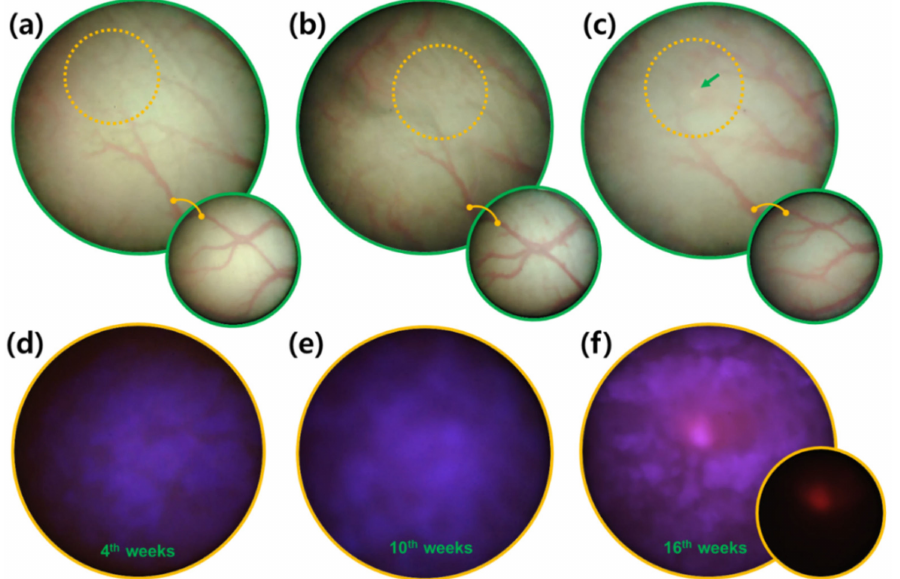
Figure 4. Tracking and monitoring of bladder cancer development. Brightfield and fluorescence images were obtained from the same bladder tissue locations at weeks ( a , d ) 4, ( b , e ) 10, and ( c , f ) 16 of BBN exposure. Orange circles in ( a – c ) brightfield images denote the approximate corresponding positions in ( d – f ) fluorescence identification based on the vascular patterns. The green arrow indicates the location of a cancer lesion. The shape of the major blood vessels is highlighted in the small lower circles in ( a – c ). The fluorescent signal (red) of the cancer tissue is highlighted in the small lower circle in ( f